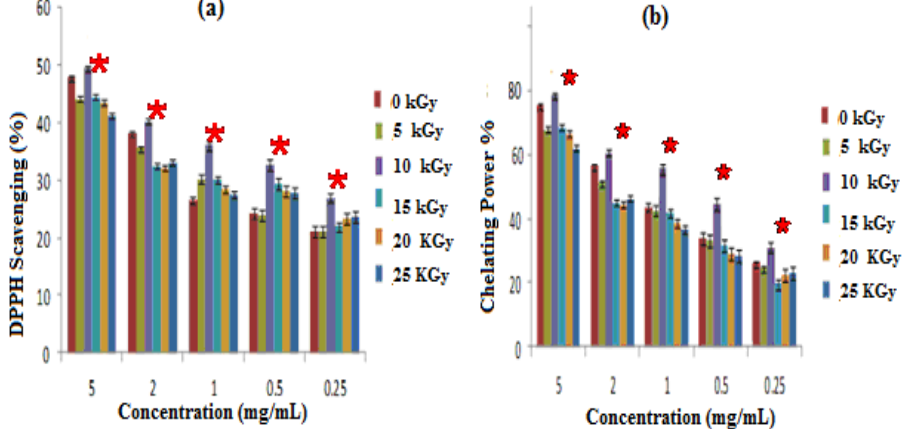
Figure 3. Antioxidative activities; irradiated gelatine–chitosan–Pomegranate peel (GEL–CH–PP) with different γ -radiation doses, 5, 10, 15, 20, and 25 kGy, in comparison with control samples (0 kGy): ( a ) DPPH scavenging activity; ( b ) Chelation Power on Ferrous (Fe 2+ ) ions. * Significant difference in the indicated group, as compared to that of the other groups at the same concentration ( p < 0.05).